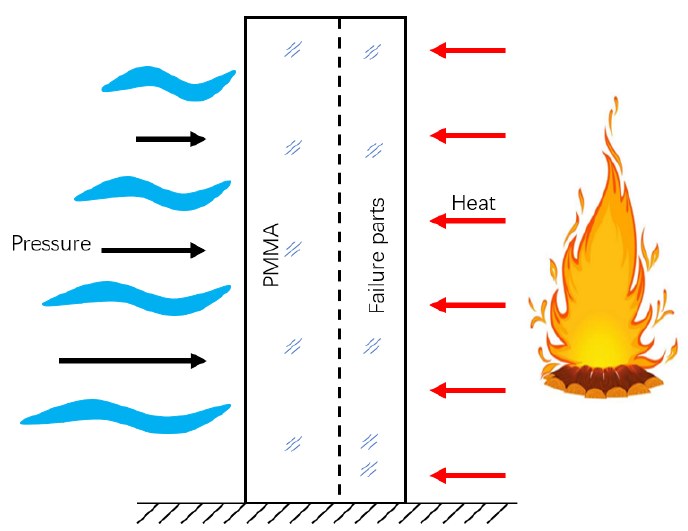
Figure 8. Aquarium heating model.